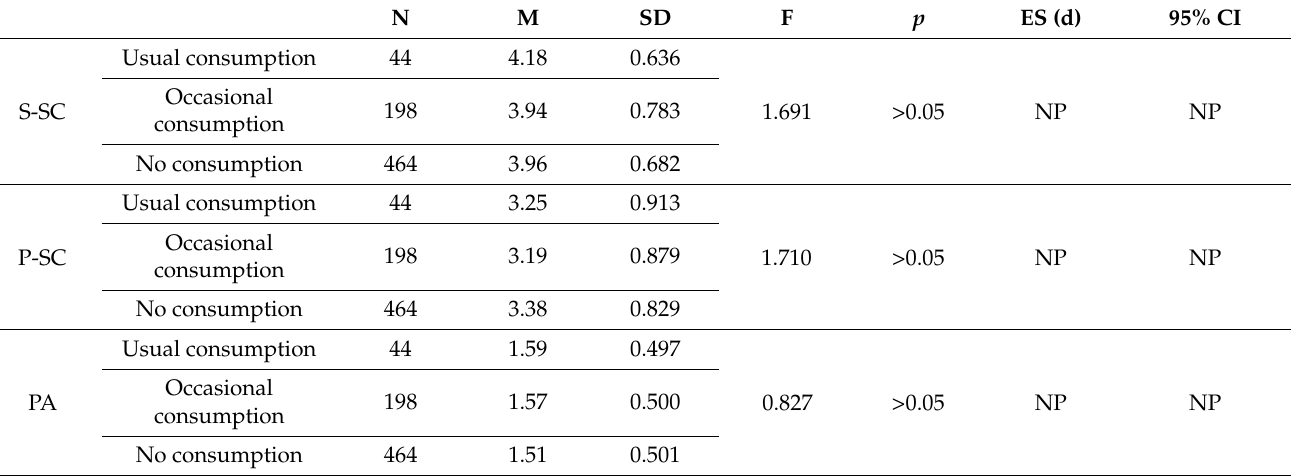
Table 2. Comparative analysis of tobacco